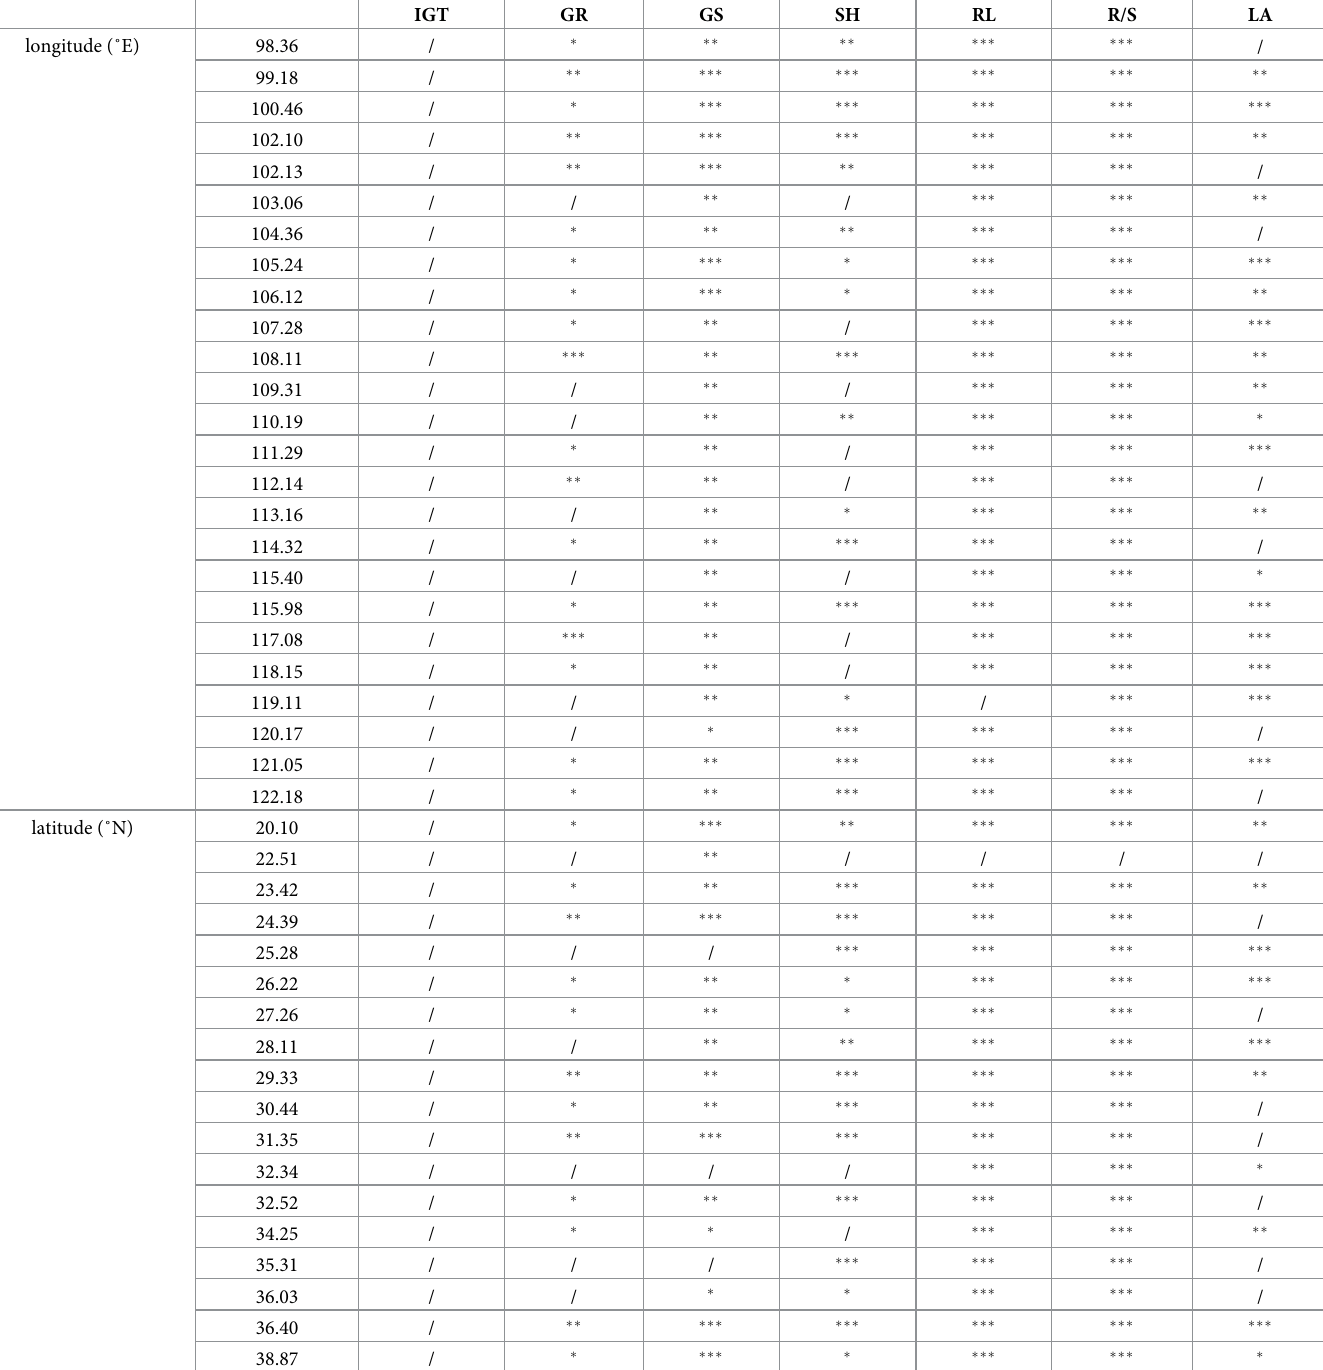
Table 2. The seed germination and seedling growth indices of L . sativa treated with A . philoxeroides aqueous extracts from the 45 sites. IGT, GR, GS, SH, RL, R/S and LA represent initial germination time, germination rate, germination speed, shoot height, root length, root length:shoot height ratio and leaf area, respectively. ‘ � ’, ‘ �� ’, ‘ ��� ’ and ‘/’ signify p < 0.05, p < 0.01, p < 0.001 and no significant effects compared with the control, respectively; bold letters means positive effects. IGT GR GS longitude